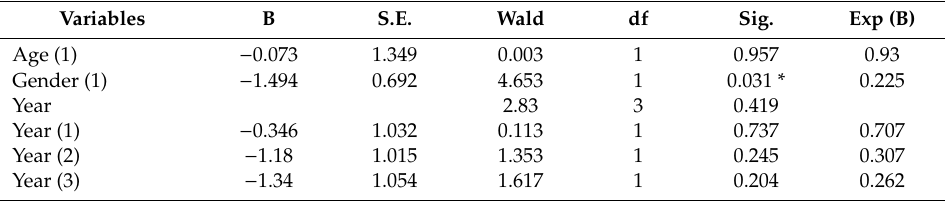
Table 3. Multinomial Logistic Regression Predicting past month cannabis use in podiatric medical